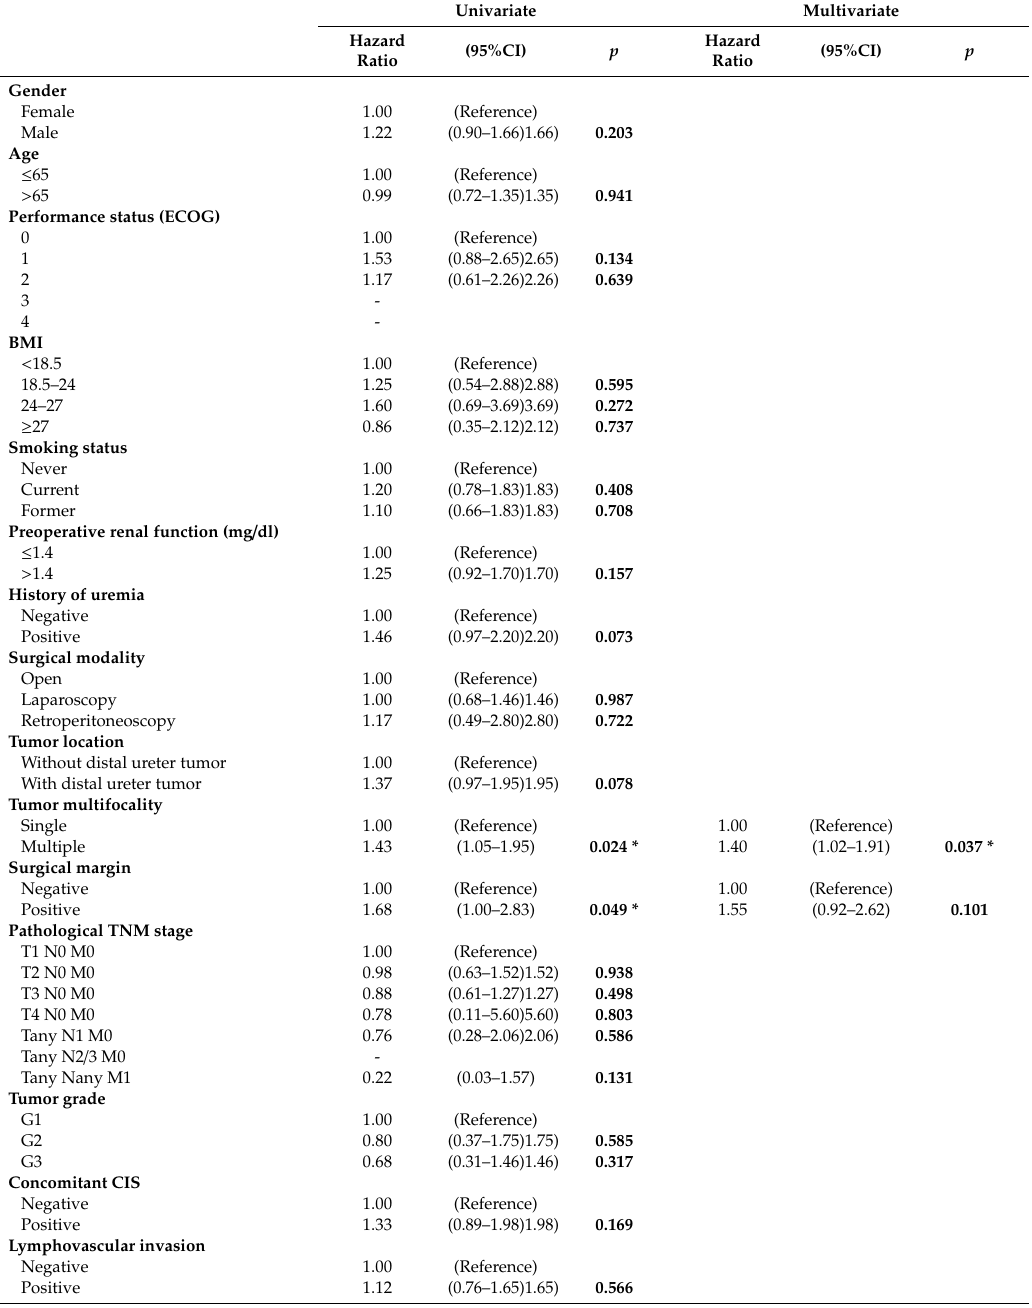
Table 2. Univariate and multivariate analyses of clinicopathological parameters predicting